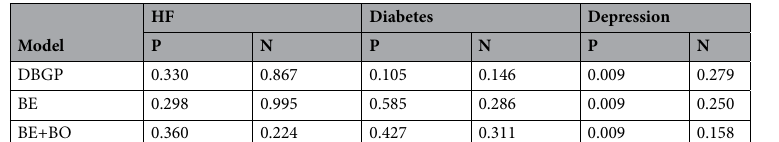
HF Diabetes Model